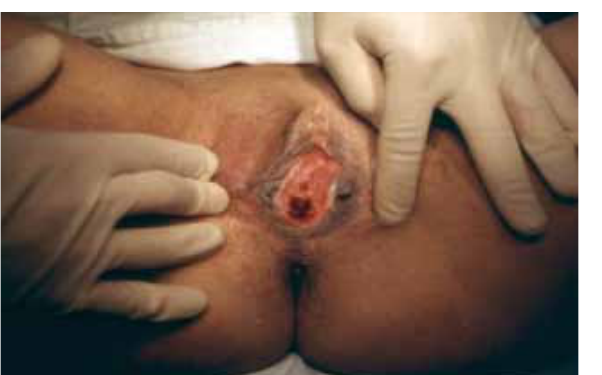
figure 4 - A postoperative case of sigmoid vaginoplasty. figure 5 - Postoperative vaginogram after sigmoid